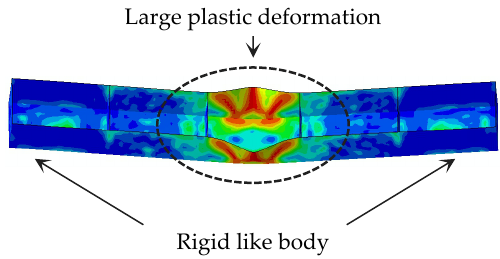
Figure 6. Deformation of sagging damage.